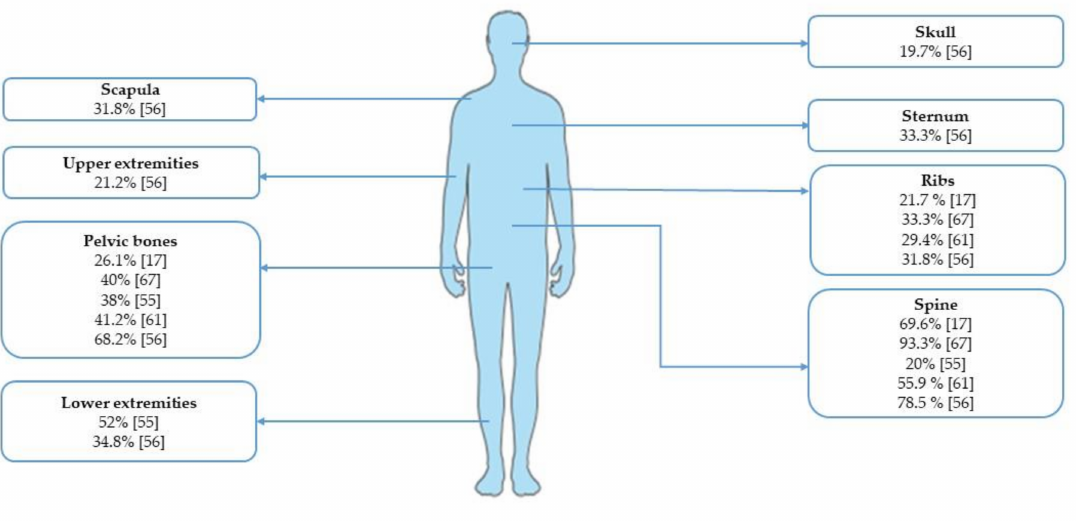
Figure 1. Incidence of bone metastases from gastric cancer according to skeletal